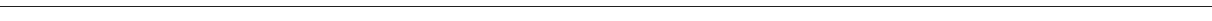
FIGURE 6 | KD cDC1 MutuDCs as compared to control DCs at 12h after CpG activation n = 2. (C) Heat-map generated from a list of manually curated genes identified from differentially regulated gene list in Zeb1 KD RNA-seq data, which includes the genes that are reported to induce Th2 responses upon activation by DCs. Major DC response genes found to be predominantly regulated after Zeb1 KD are highlighted in bold. To generate this bar-graph Z-score was calculated for each gene from normalized FPKM values to demonstrate the differential regulation of genes in control and Zeb1 KD DCs at 0, 6, and 12h after CpG activation. (D) Bar-plot depicting the number of genes differentially regulated in Zeb1 KD DCs at 0, 6, and 12h CpG activation as compared to control DCs. Different color codes indicate the genes that are unique or similar in the list of differentially regulated genes at different time points (0, 6, and 12h). (E) Bar-plot depicting the biological pathways that were significantly enriched for the genes that differentially regulated after Zeb1 KD in 6 and 12h CpG activation as compared to control cells. Ingenuity Pathway Analysis (IPA) was used to perform pathway enrichment